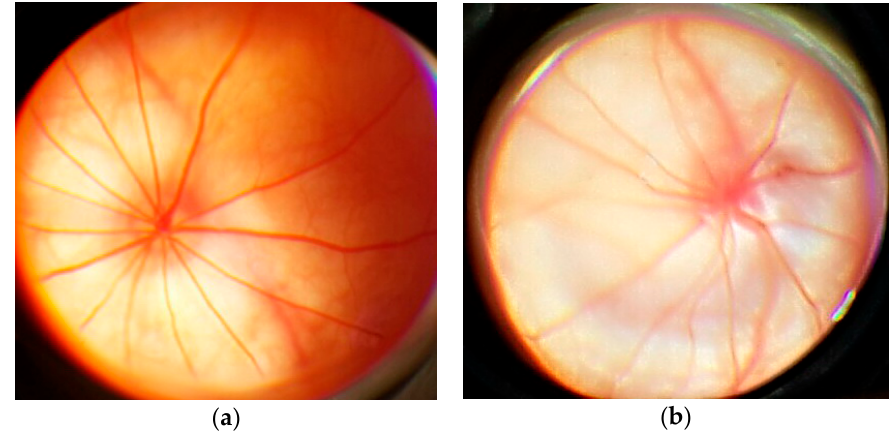
Figure 4. An example of an ophthalmoscopic picture in rats: ( a ) in control group; ( b ) with the simulated retinal ischemia-reperfusion.